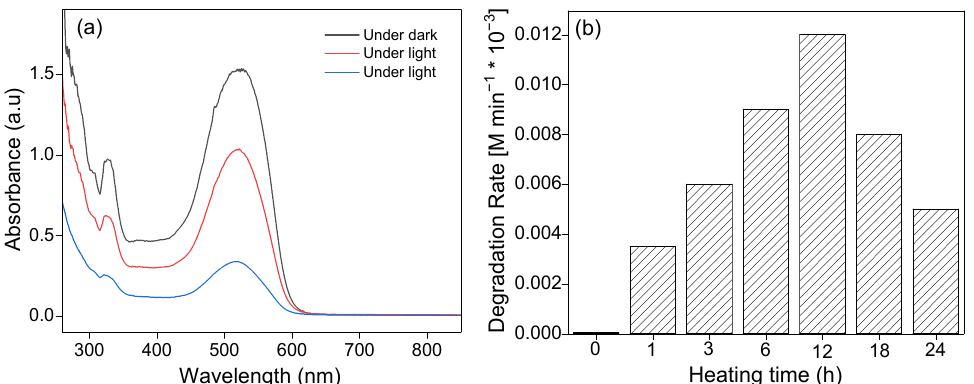
Figure 5. ( a ) Change in absorption spectra of amaranth before and after photocatalytic reaction and ( b ) change in degradation rates in the presence of nanotubes and samples obtained after post-hydrothermal heat treatment at 120 °C for different time intervals. Table 1. BET and anatase crystallite size of as-prepared and heat-treated samples.